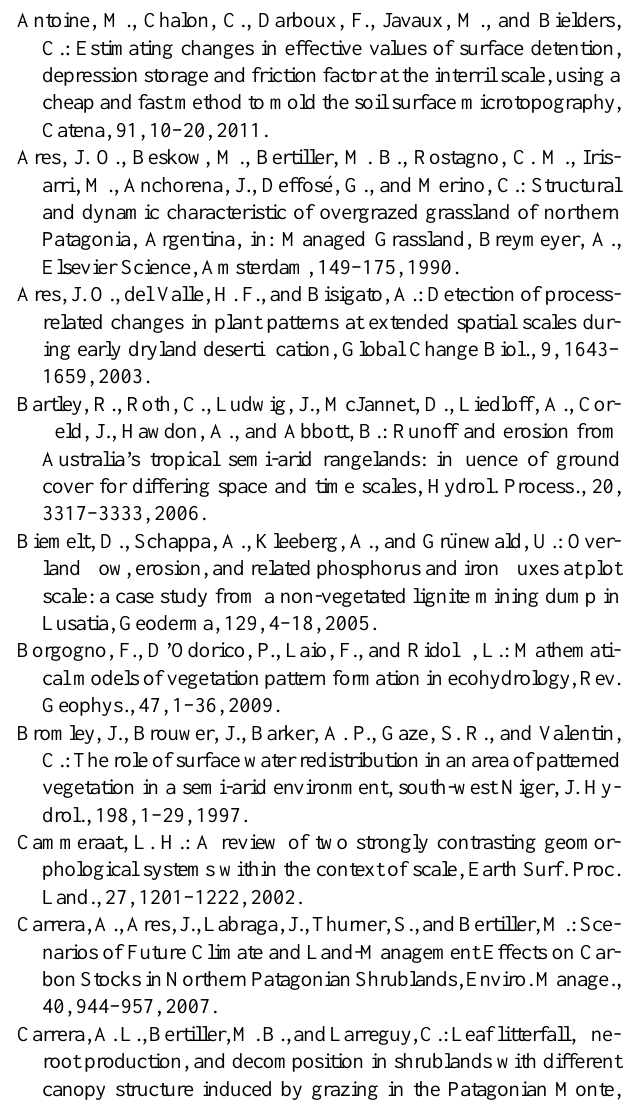
Fig. A1. Schematic representation of parameters involved in considering infiltration up to depth z f of a water inflow W on sloping soil with partially ponded depressed areas (A- C) (Also see main text, Figure 2).